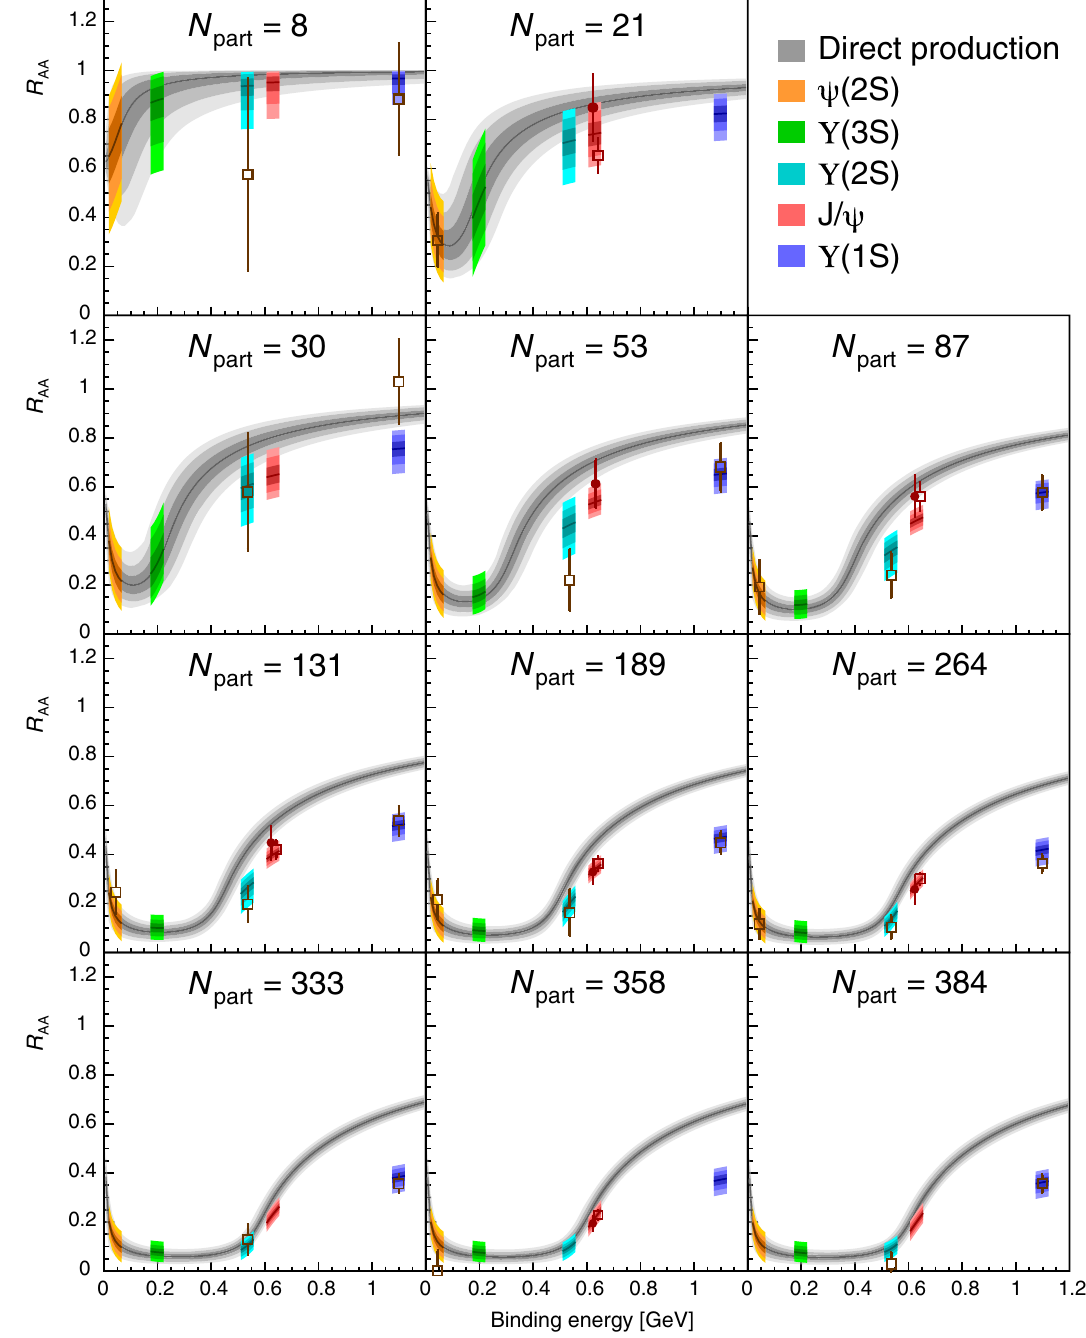
Fig. 7 Comparison, as a function of the binding energy, between the data reported by CMS (closed markers) and ATLAS (open markers), at approximately the same average N part , and the corresponding global-fit results for R inc correlation patterns observed [4] in the precise and detailed 7 and 13TeV pp data [5–10]: S-wave quarkonium produc- tion in pp collisions can be parametrized assuming that the transition probability from the pre-resonant QQ state to the physically observable bound state is simply proportional to a power law in the binding energy, P ( QQ → Q ) pp ∝ E δ